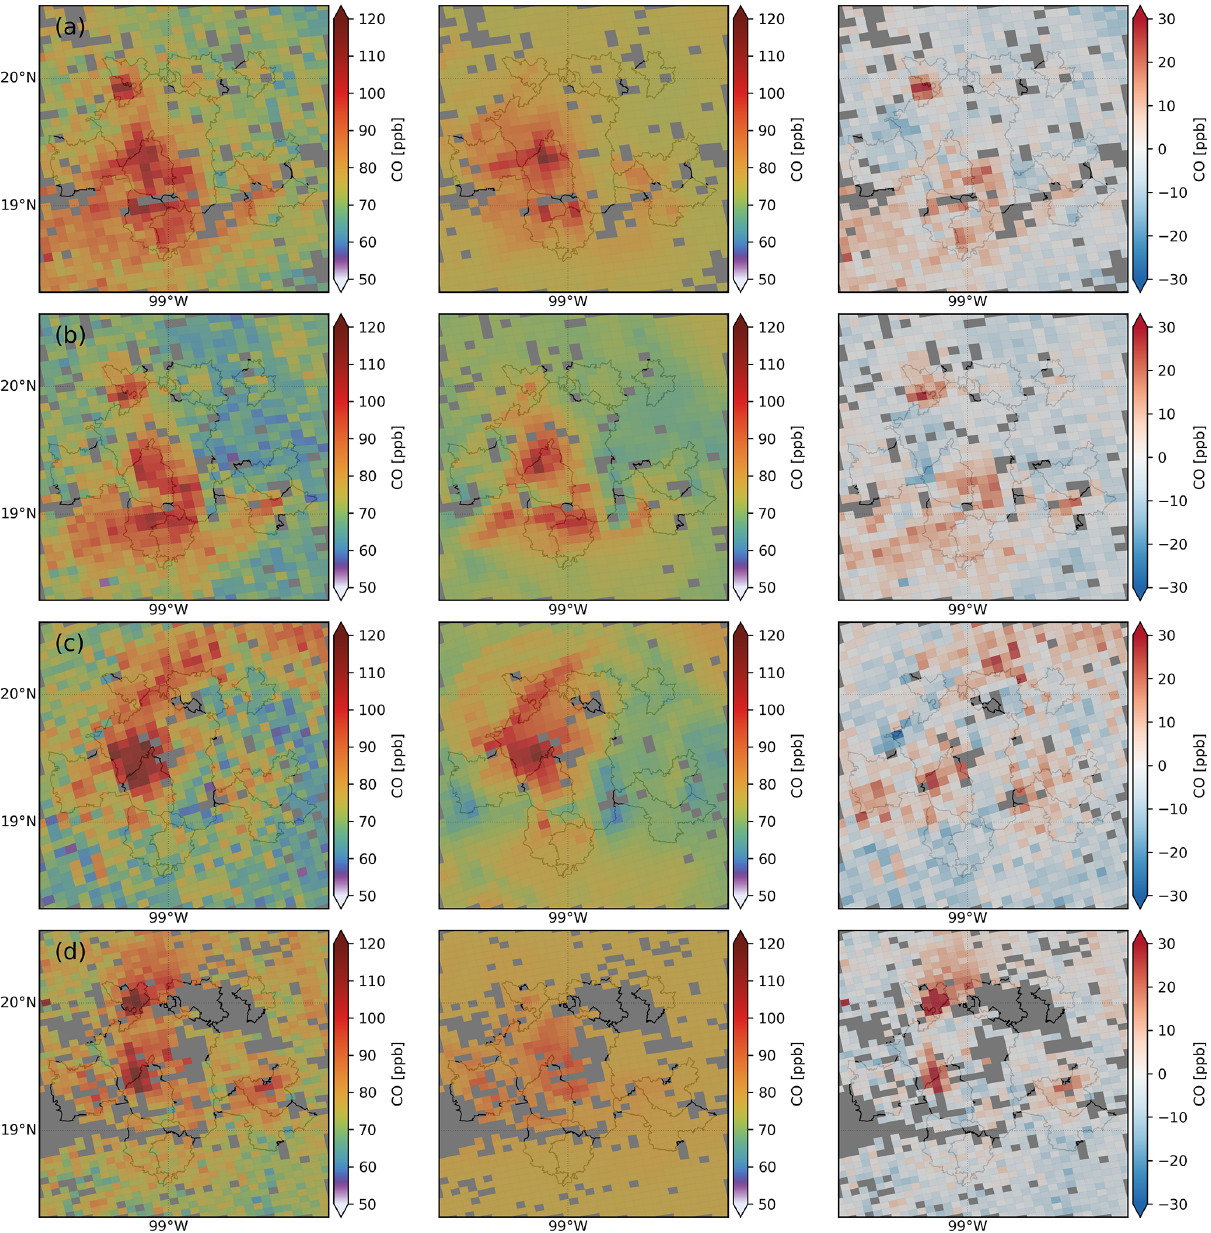
Figure 4. Example cases for fitting the WRF-Chem simulation to the TROPOMI data deploying the “final-fit” approach for (a) 20 September, (b) 7 November, (c) 19 November 2018, and (d) 17 August 2019. TROPOMI CO retrievals (left column), WRF-Chem simulation fitted to the TROPOMI data (middle column), and the residual (right column, TROPOMI –